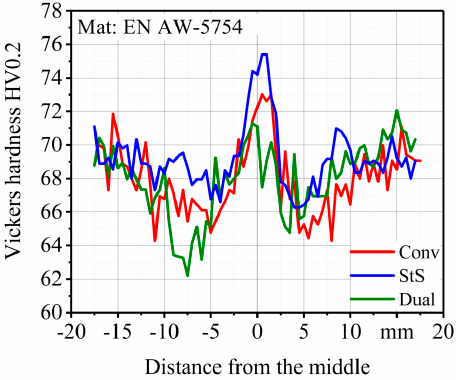
Figure 15. Microhardness profile at the surface of the friction stir welded (FSW) specimens.